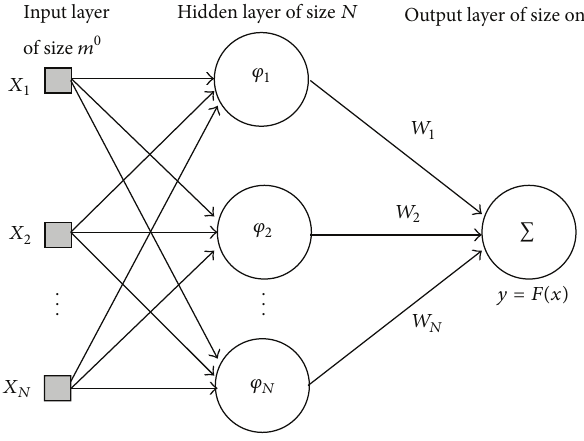
Figure 5: Structure of RBF neural network model.